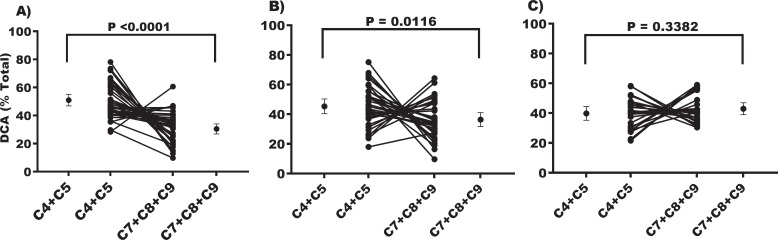
Changes in energy versus oxidative DCA species in clinical groups.A) Individual line graphs and the means (± 95% CI) of C4+C5 and C7+C8+C9 in urine from CH-NAT study participants. B) Separate line graphs and the mean (± 95% CI) of C4+C5 and C7+C8+C9 in urine from CH-PAT study participants. C) Individual line graphs and the means (± 95% CI) of C4+C5 and C7+C8+C9 in urine from CH-NAT study participants.